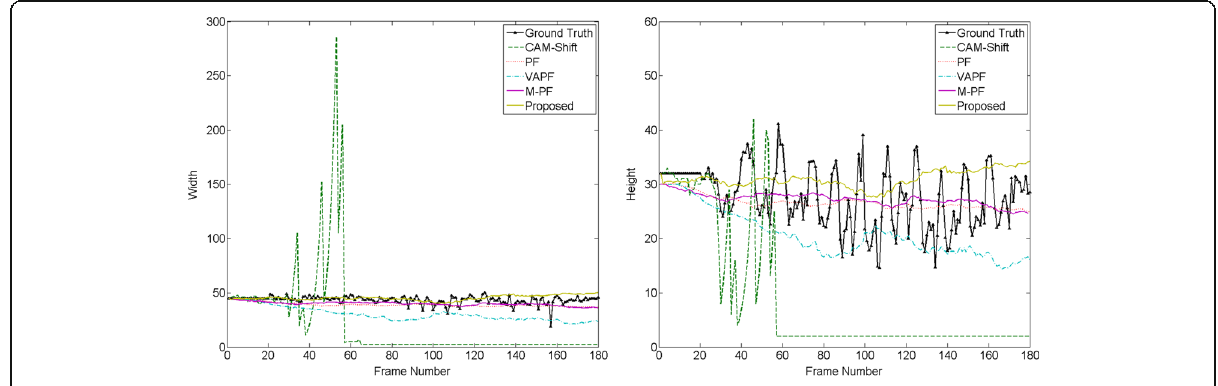
Fig. 25 Estimated width and height of “ book ” compared with ground truth with the particle number N = 250